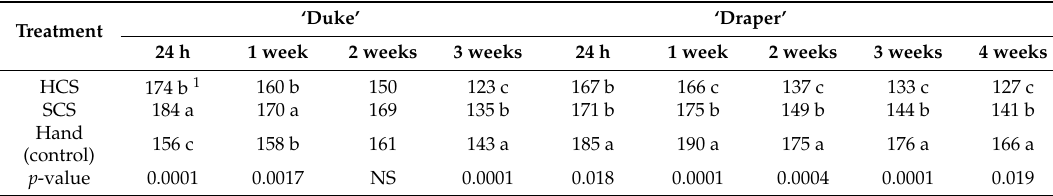
Table 2. Firmness (g/mm) of ‘Duke’ and ‘Draper’ blueberries 24 h and 1, 2, 3, and 4 weeks after machine harvesting with hand-held pneumatic shakers used by workers standing on a platform built into a modified over-the-row harvester prototype with experimental hard and soft catch surfaces (HCS and SCS, respectively) in Oregon. Machine harvested berries were compared to hand-harvested (control) fruit in